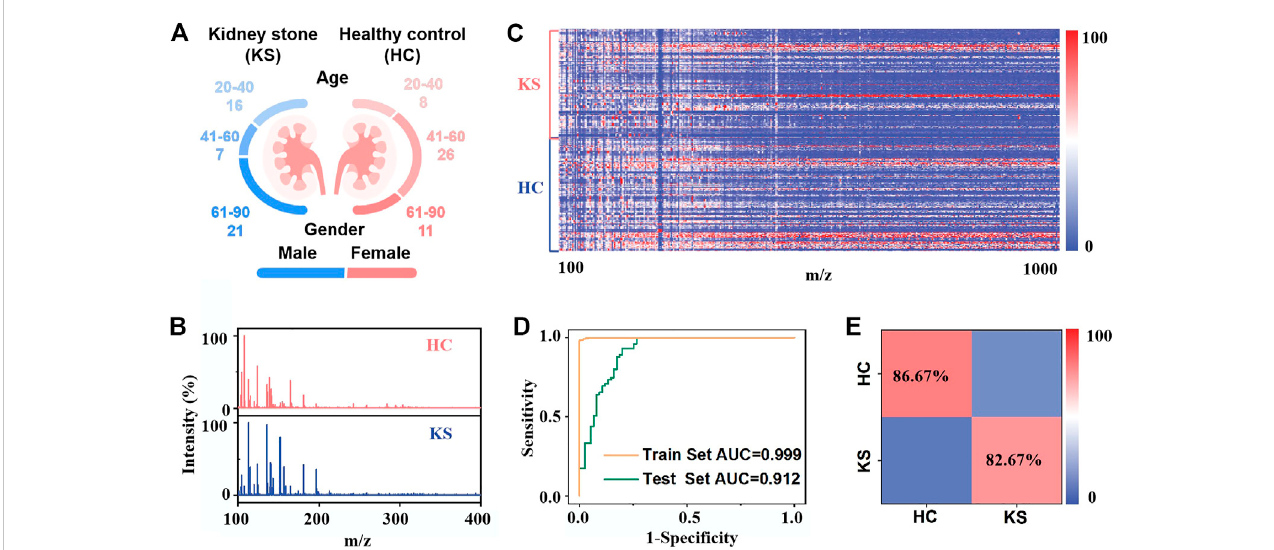
FIGURE 4 On-chip in vitro metabolic diagnosis of KS patients: (A) Age distribution of 44 kidney stone patients and 45 healthy controls. (B) Typical mass spectra of kidney stone patients and healthy controls. (C) Heat map of independent metabolic fi ngerprinting for urine from 44 kidney stone patients and 45 healthy controls wasplotted,usingsignals within m/z range from100 to1,000 throughdata preprocessing.The colorscale wasprocessedbylogarithmiccorrection. (D) Receiveroperatingcharacteristic(ROC)curvesbasedonurinemetabolicchangestodistinguishKSpatientsfromhealthycontrols,withanAUCvalue of 0.999 for the train test (yellow line) and 0.912 for the blind test (green line). (E) The confusion matrix from blind test to differentiate 15 KS patients from 15 healthy